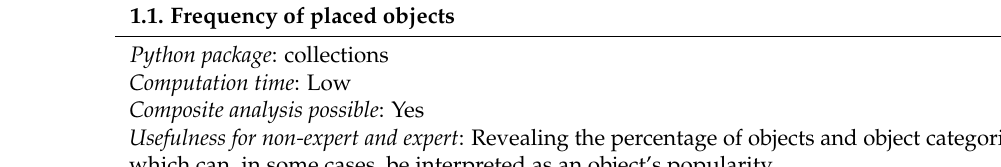
Table 2. Analysis methods for crowdsourced map-based